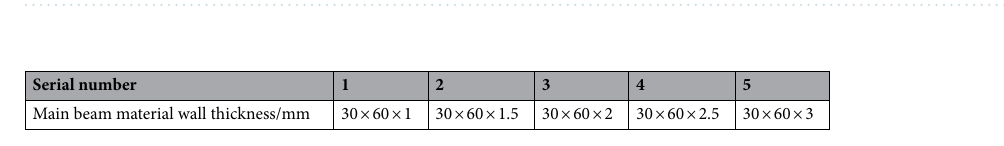
Table 3. Wall thickness of main beam